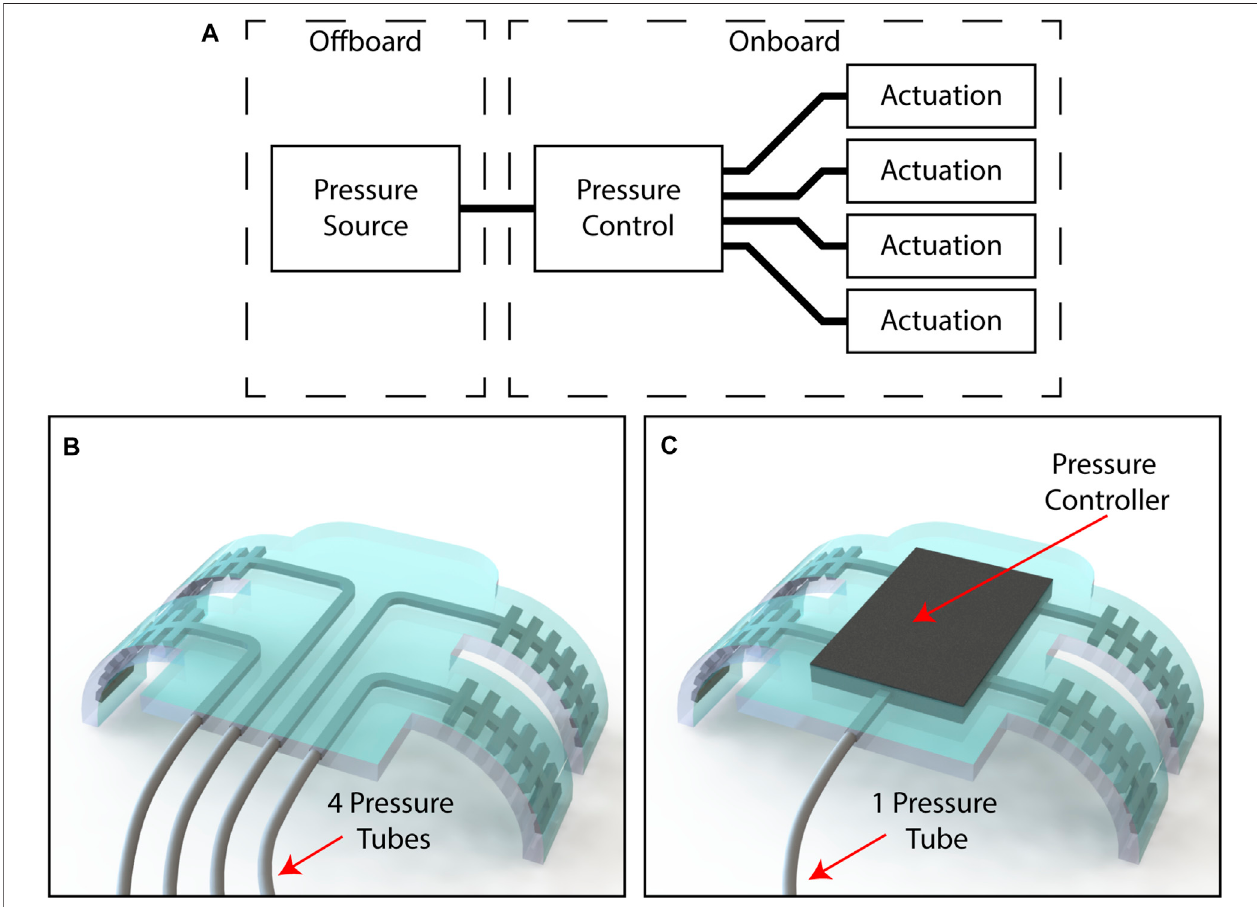
FIGURE1|(A) Ablockdiagramdepictingthecomponentsthatarerequiredforamulti-DoFssoft fl uidicrobot (B) afourDoFsrobotrequiringfourtubestointerface with an external pressure supply, and (C) a four DoFs robot requiring only one tube to interface with an external pressure supply due to its onboard pressure controller.